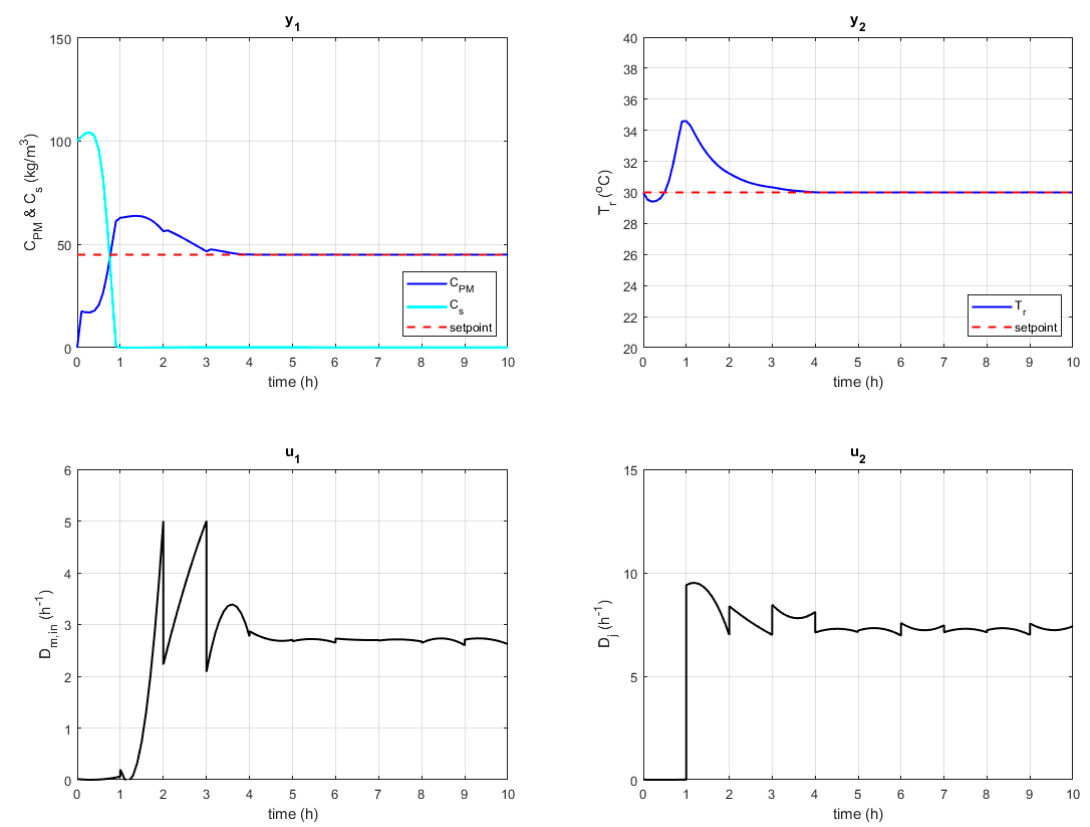
Figure 13. Case 2—closed-loop simulation with sustainability constraint: output (y 1 and y 2 ) and input (u 1 and u 2 ) profiles.